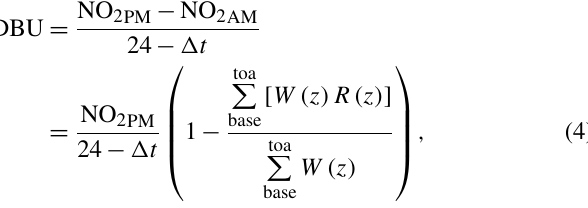
negative decadal trend in their DBUs, ranging from − 8 to − 14 %, revealing either a reduction of N